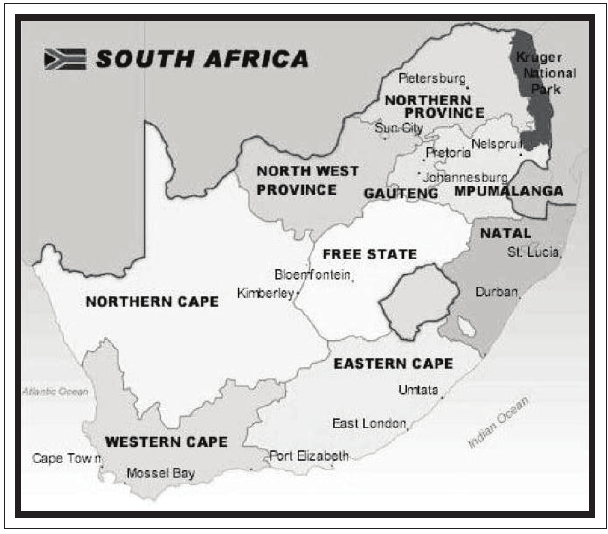
FIGURE 2: Kruger National